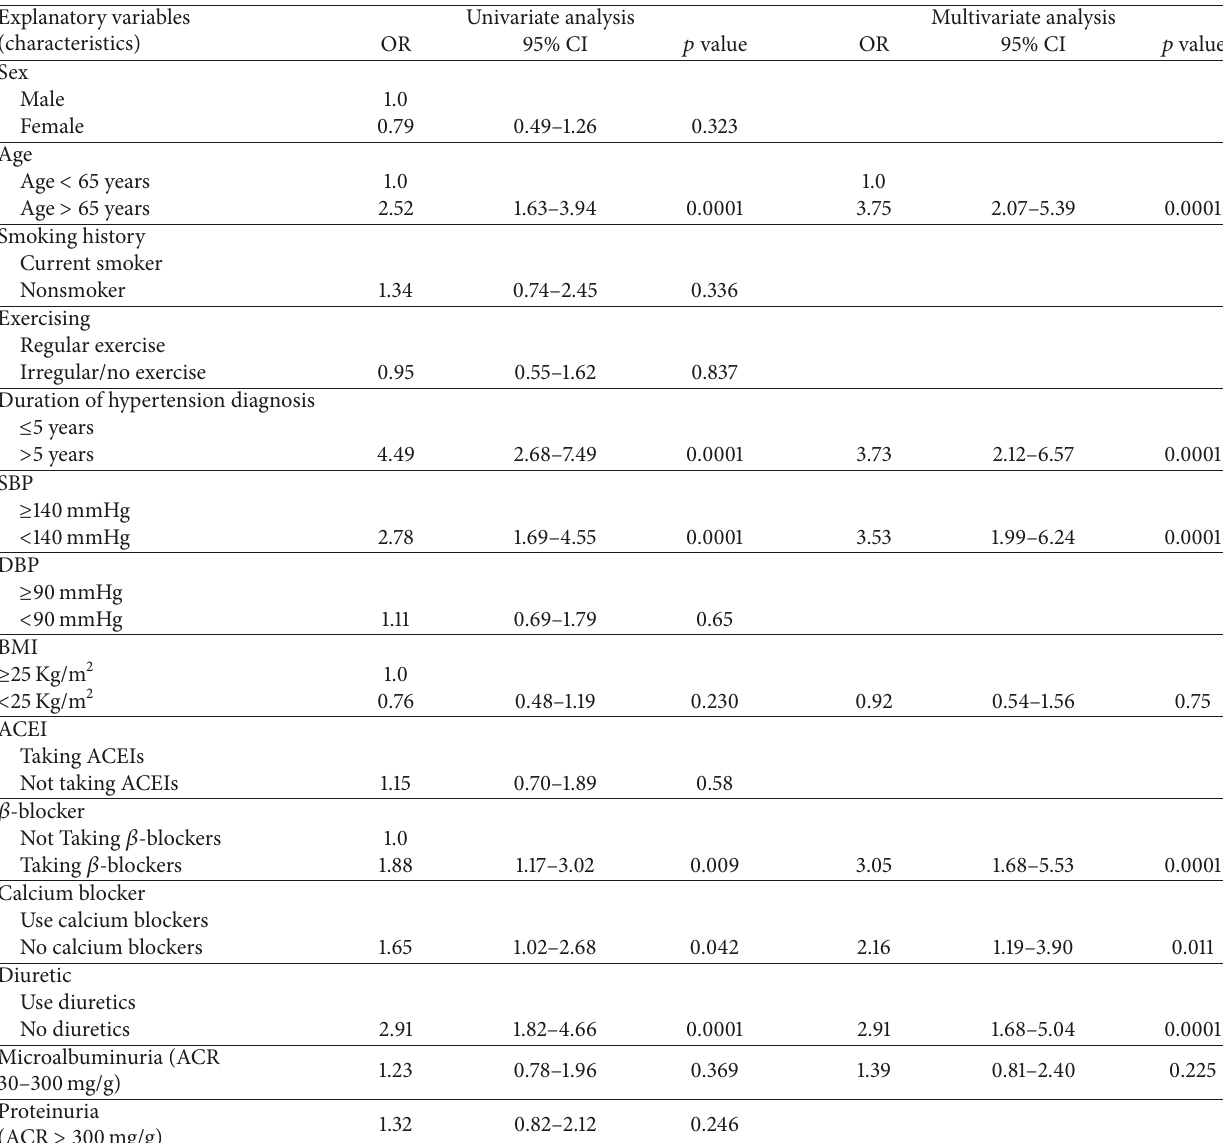
Table 2: Logistic regression analysis of factors associated with retinopathy at Mbarara Regional Referral Hospital, Mbarara, Uganda ( 𝑛 = 334